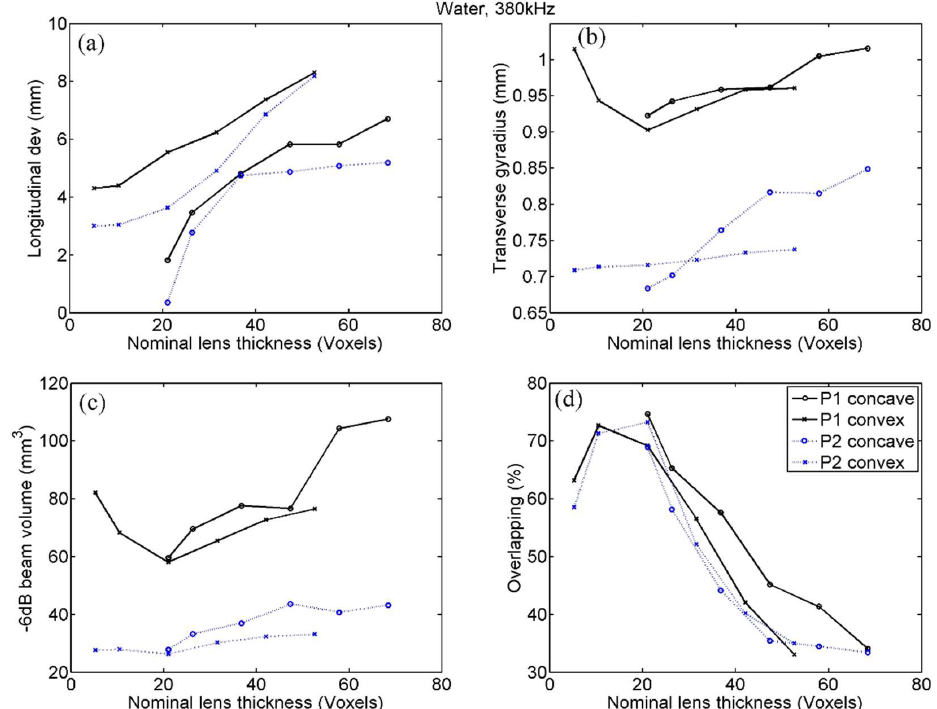
Figure 7. Focusing quality indicators calculated by simulation in water with 380 kHz, at points P1, and P2, for concave (fast) and convex (slow) lenses. Indicators are the following: ( a ) Longitudinal deviation, ( b ) transverse gyradius, ( c ) beam volume and ( d ) energetic overlapping.